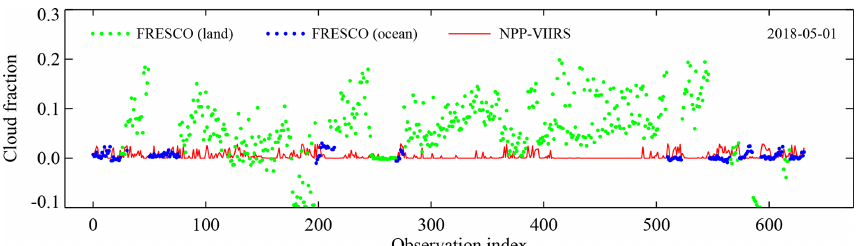
Figure 4. Cloud fractions calculated from TROPOMI FRESCO and NPP-VIIRS observations for all cloud-free 1 ◦ × 1 ◦ latitude–longitude boxes on 1 May 2018. The FRESCO data are plotted in green over land and in blue over the ocean. The NPP-VIIRS cloud fractions, plotted in red, are all close to zero, as expected, because they were used for the cloud screening. The large deviations from zero found in the FRESCO cloud fractions over land are primarily the result of inadequate (nondirectional) surface albedo information provided to the FRESCO retrieval algorithm, resulting in large errors in the FRESCO cloud fractions for certain scattering